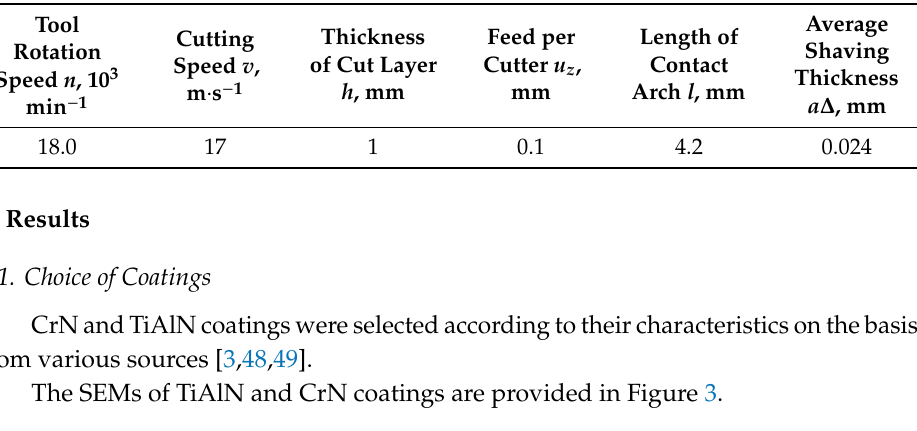
Table 4. Milling